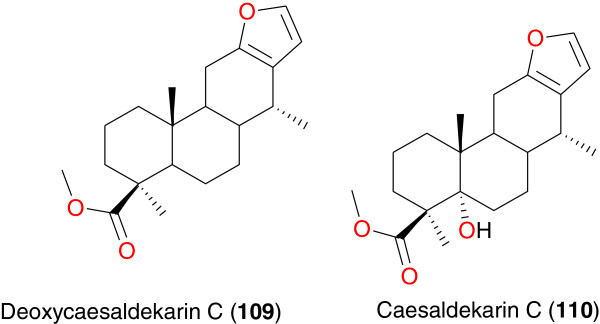
Promising anti-malarial cassane furanoditerpenes from African medicinal plants.